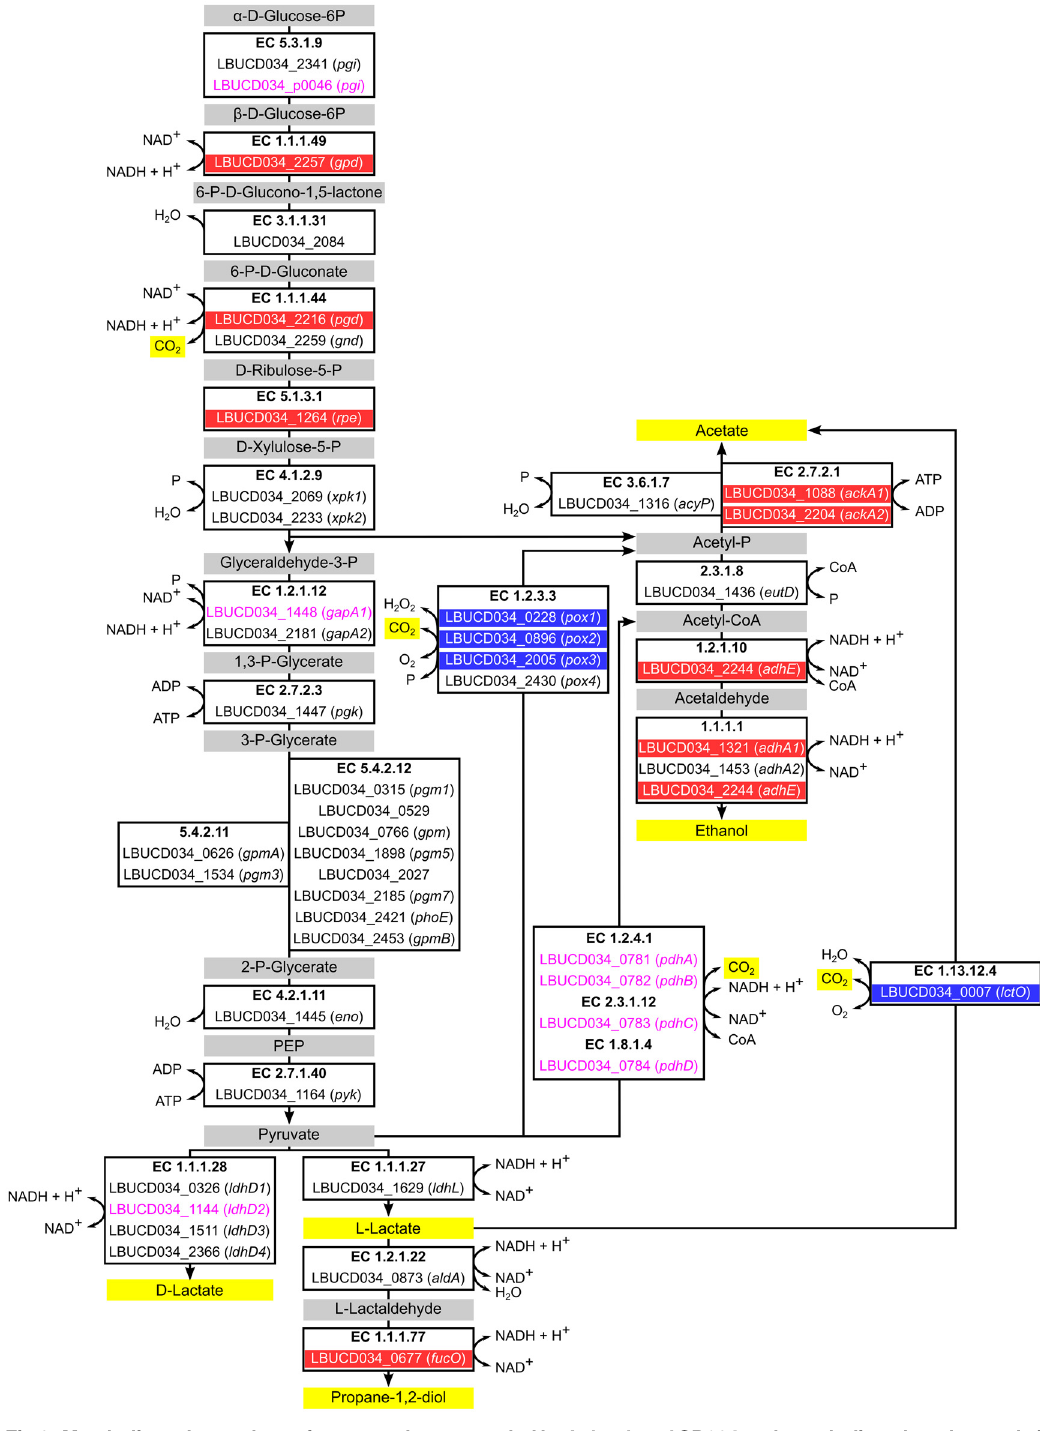
Fig 3. Metabolic pathway chart of gene products encoded by L . buchneri CD034 and metabolites that play a role in heterolactic fermentation. Genes are represented by their locus tag and the gene name, if applicable. Locus tags and gene names with highlighted background indicate genes that were found to be up-regulated (blue) or down-regulated (red) under aerobic vs . anaerobic conditions. Locus tags and gene names printed in pink indicate genes that were found to be highly transcribed. Pathway end products (yellow) and intermediates (gray) are also highlighted.